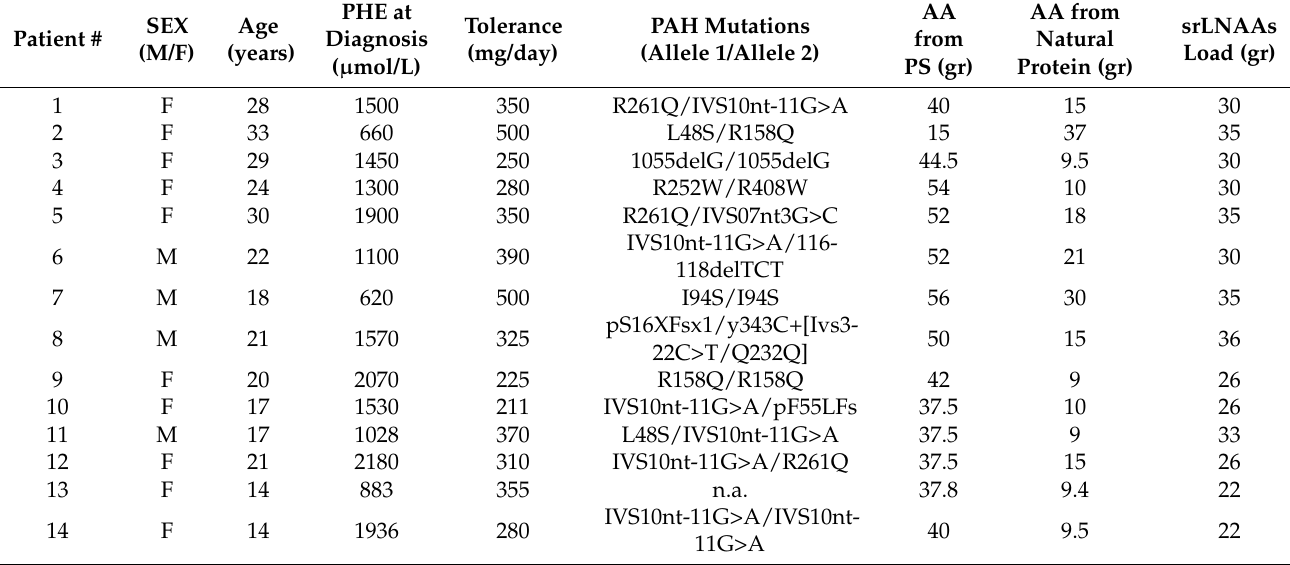
Table 1. Patients’ demographics, phenotype, genotype and dietary amino acid